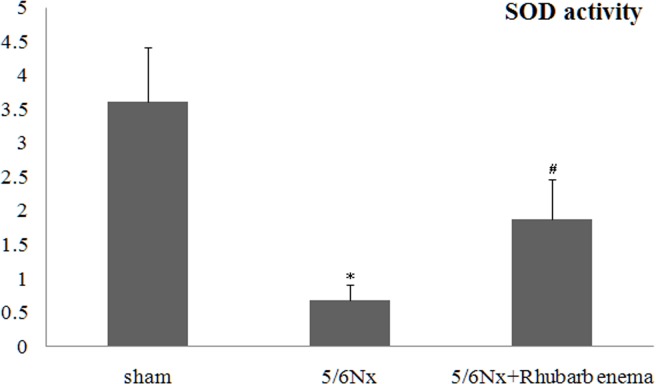
Superoxide dismutase activity assays.Sham operation group rats showed higher SOD values, but SOD activity in 5/6 nephrectomized rats (5/6Nx) was significantly decreased. *P < 0.05 vs sham group. The value of SOD activity in the group treated with rhubarb enema was significantly higher than that in the 5/6Nx group. #
P < 0.05 vs 5/6Nx group.